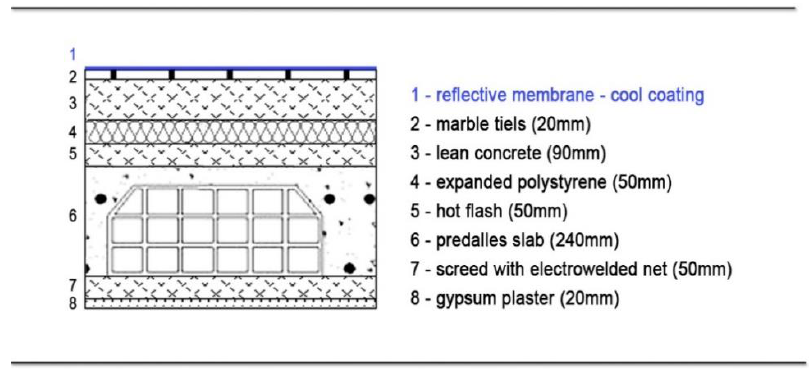
Figure 6. Roof covering with the addition of cool roof layer.